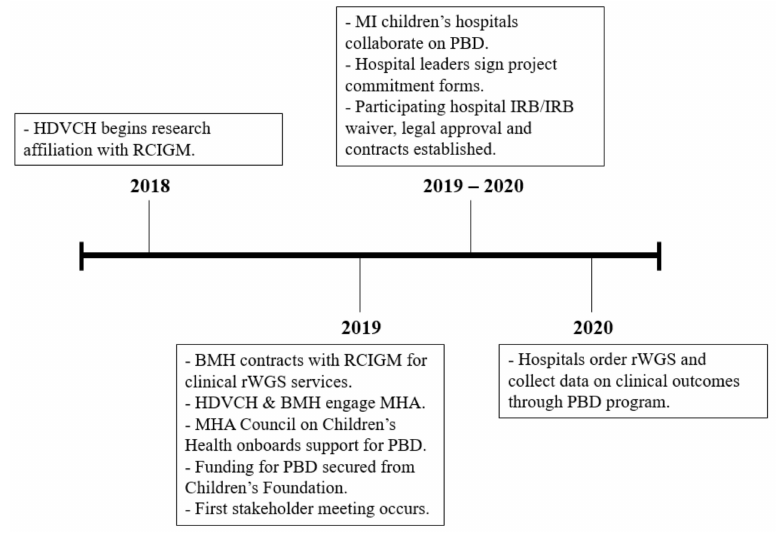
Figure 1. Timeline for Project Baby Deer. Table 2. Project Baby Deer Hospital Site Characteristics. Onboarded